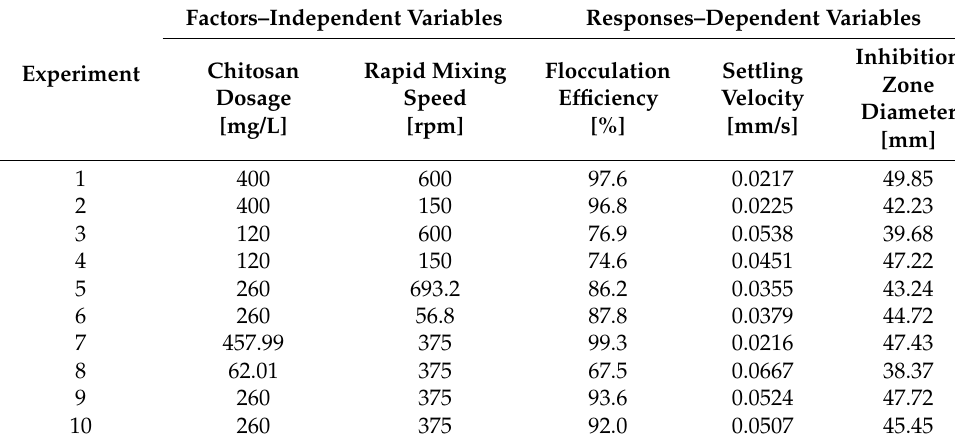
Table 2. Experimental design and responses for winery flotation effluent.